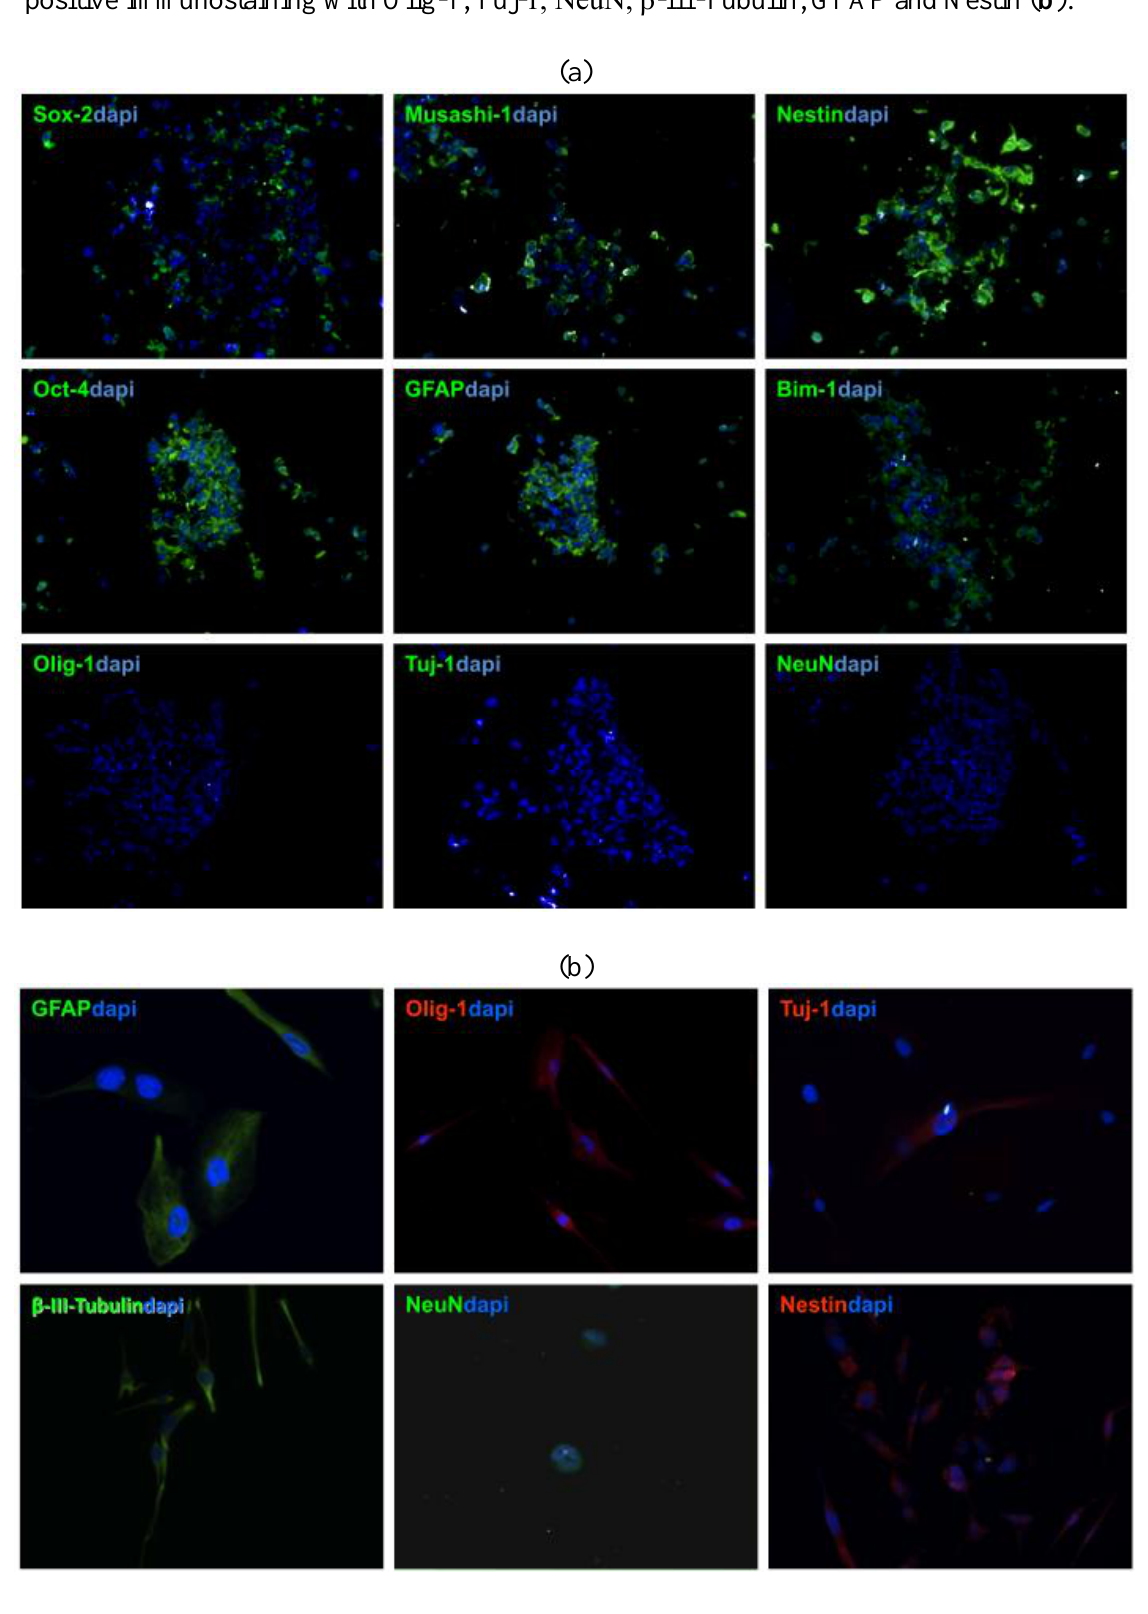
Figure 3. Stemness and Differentiation. Stemness of GBM stem cells is characterized by positive immunoreactivity with Sox-2, Musashi-1, Nestin, GFAP and Bim-1 and absence of expression of Olig-1, Tuj-1 and NeuN ( a ) and induced differentiation of GBM stem cells, positive immunostaining with Olig-1, Tuj-1, NeuN, β-III-Tubulin, GFAP and Nestin ( b